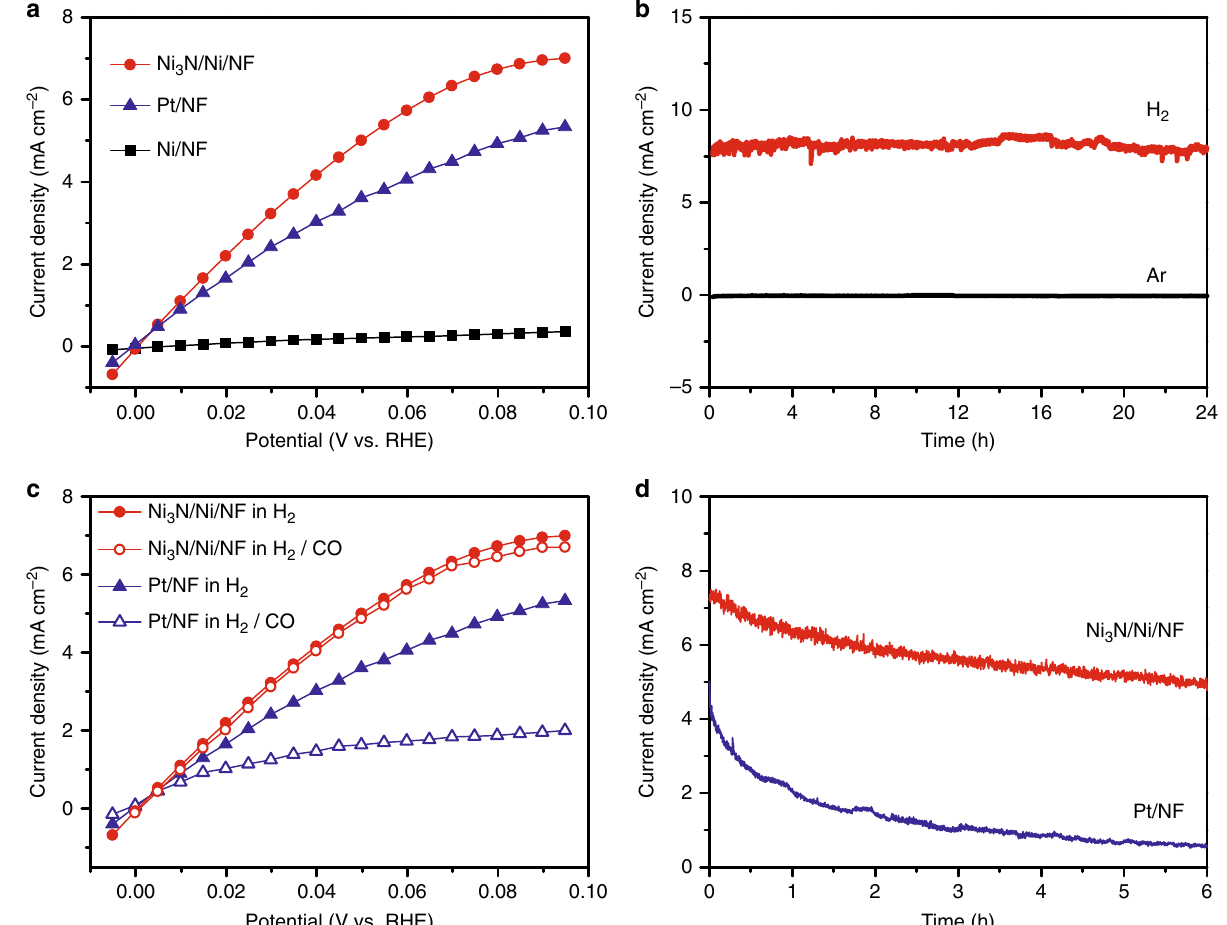
Fig. 4 The electrocatalytic performance for HOR. a Steady-state polarization curves of Ni 3 N/Ni/NF, Ni/NF, and Pt/NF for HOR in H 2 -saturated 0.1 M KOH. b Chronoamperometry curves of Ni 3 N/Ni/NF in H 2 - or Ar-saturated 0.1 M KOH measured at 0.09 V vs. RHE. c Comparison of the HOR polarization curves of Ni 3 N/Ni/NF and Pt/NF in 0.1 M KOH saturated with H 2 or H 2 with 2% CO (v/v). d Chronoamperometry curves of Ni 3 N/Ni/NF and Pt/NF in 0.1 M KOH saturated with H 2 with 2% CO (v/v) measured at 0.09 V vs. RHE. All results were collected without iR compensation. The current densities were calculated on the basis of the geometric electrode